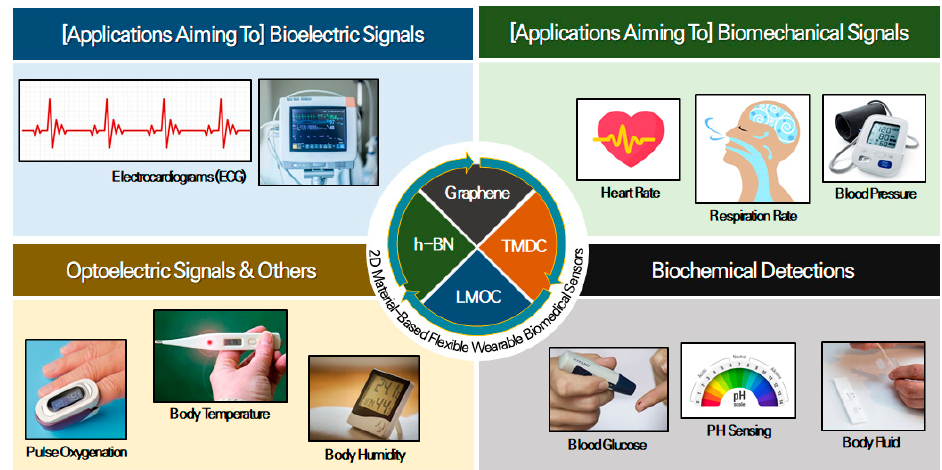
Figure 1. Summary of applications in the field of biomedical sensors, which can be potentially achieved by flexible electronics-based wearable devices using two-dimensional (2D) materials. Only copyright-free images are included in the figure.